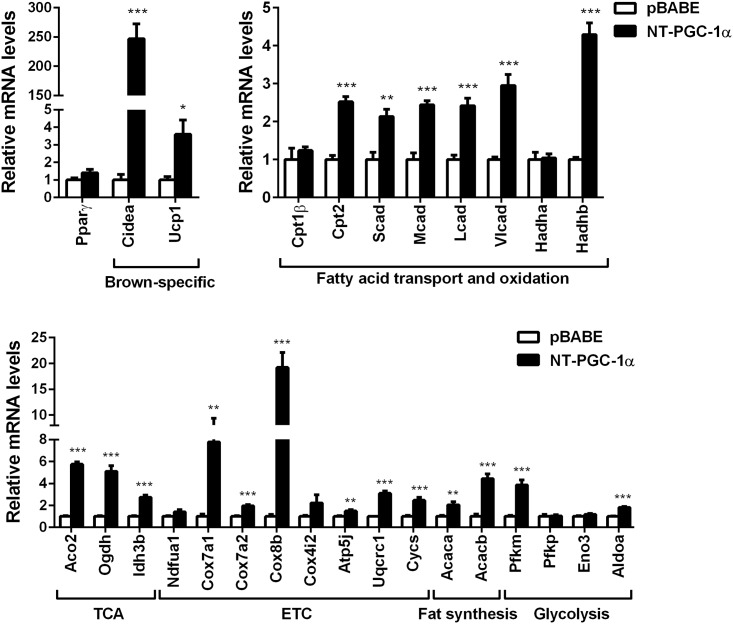
The effect of NT-PGC-1α on candidate gene expression in 3T3-L1 adipocytes.Quantitative real-time PCR analysis of gene expression in 7-day-differentiated 3T3-L1 adipocytes expressing pBABE empty vector or NT-PGC-1α-a (n = 6). Empty vector vs NT-PGC-1α: *P < 0.05, **P < 0.01, ***P < 0.001.